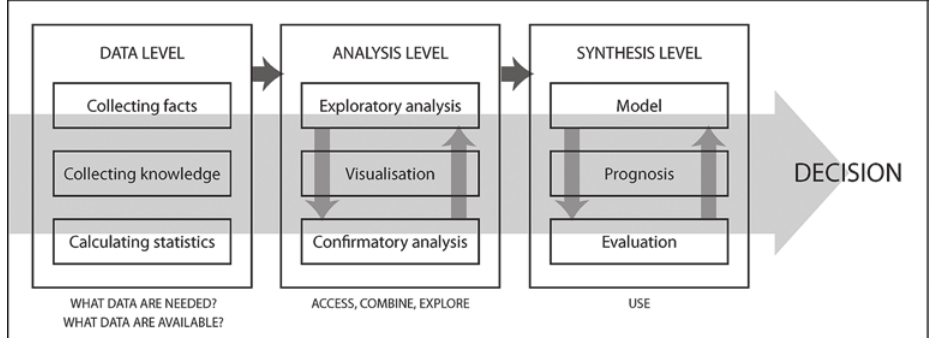
Fig. 2. Spatial methods in decision